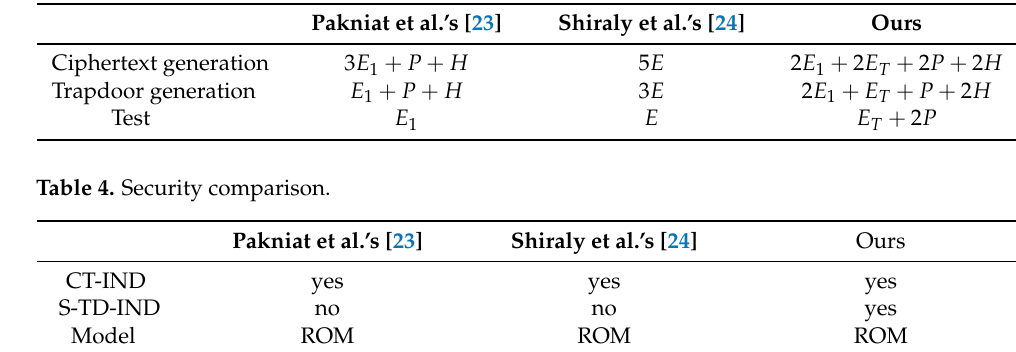
Table 3. Computation overhead comparison.